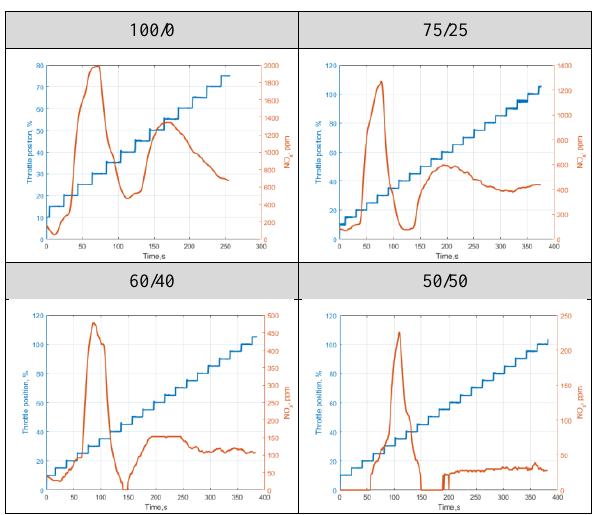
Fig. 10. Concentration of NO x in the exhaust gases at supply of different gas mixture NO concentration in the exhaust gas corresponding to x the area of maximum efficiency is for the fuel supply with a high methane content (100/0) many times higher than for the case of its low volume fraction (50/50).